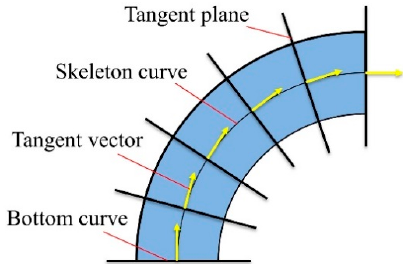
Figure 6. The slicing method of pipe parts model.